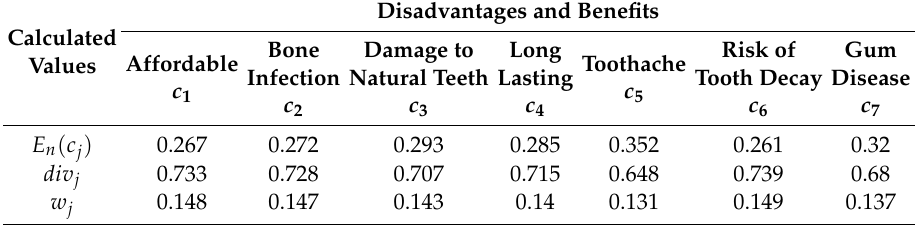
Table 11. Entropy